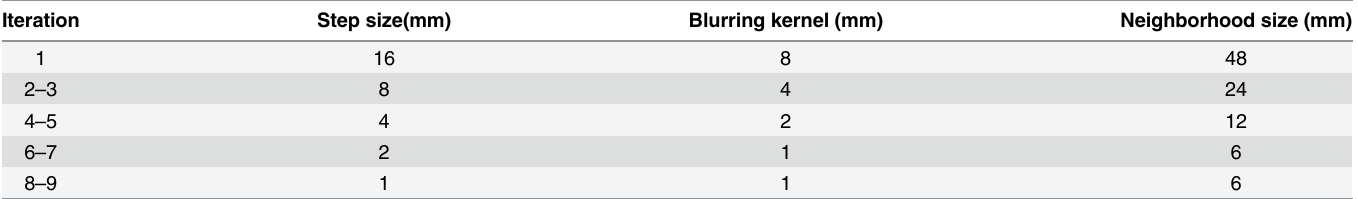
Table 2. ANIMAL non-linear registration schedule. For each iteration, we define a step size as the distance between control nodes for the free-form defor- mation recovered. The blurring kernel is the size of the full-width-half-maximum of the Gaussian kernel used to blur the source and target data. The local cor- relation which defines the local similarity is estimated in the neighborhood of diameter equals to the neighborhood size parameter.